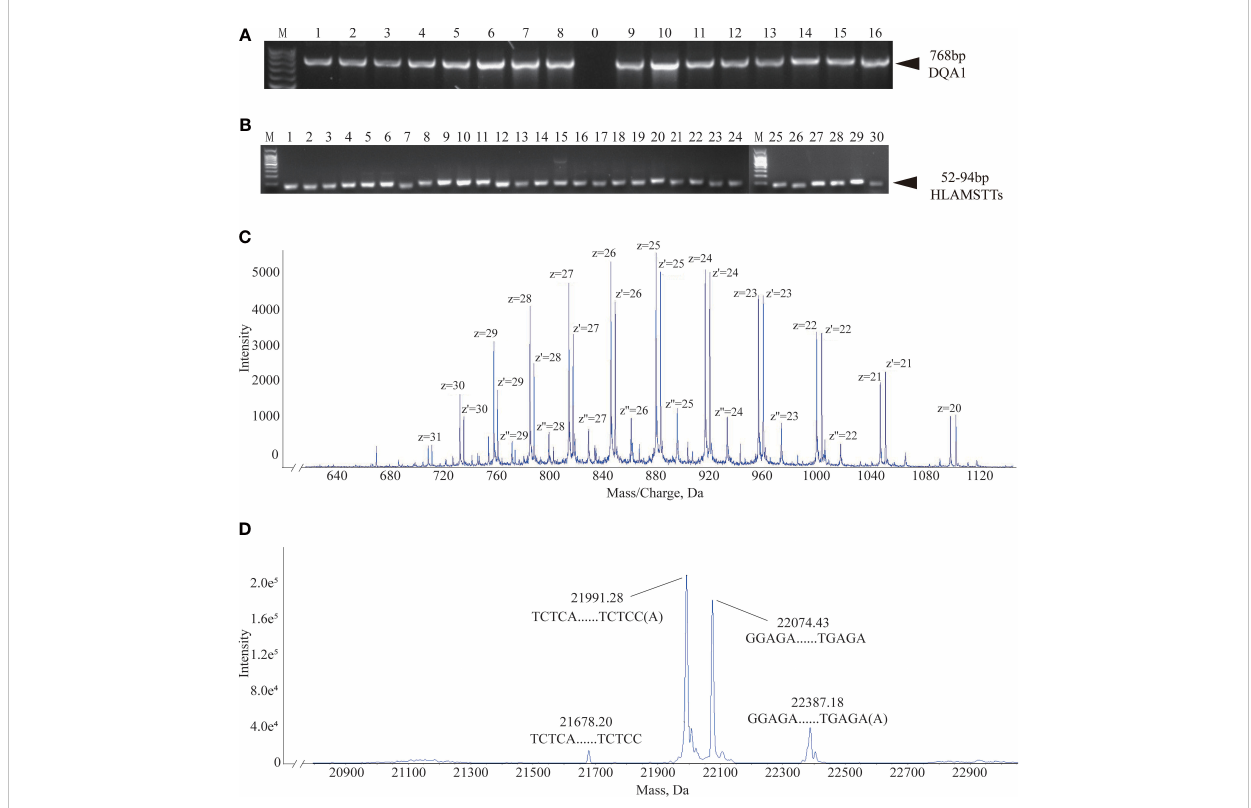
FIGURE 4 Agarose gel electrophoresis and MS data interpretation. (A) Agarose gel electrophoresis of 16 HLA-DQA1 showed bands at 768 bp. (B) HLAMSTT gel electrophoresis of Sample 2 showed bands at 52 – 94 bp. (C) Mass spectrum of Sample 2 No. 26 HLAMSTT with corresponding mass-to-charge ratio (m/z) peaks. The m/z of the HLAMSTT was between 700 and 1100 Da, and the maximum intensity of the signal was between 5000 and 6000. (D) Mass spectrum of Sample 2 No. 26 HLAMSTT with corresponding molecular weight peaks. The molecular weights of the two highest peaks were 21992.11 Da and 22075.32 Da, corresponding to the DNA single strands TCTCAGGCTCCCAGTGTTTCAGAAGAGGCTGGTCCAGGCCCCAGTGCTCC ACCTTGCAGTCATAACTCTCC(A) and GGAGAGTTATGACTGCAAGGTGGAGCACTGGGGCCTGGACCAGCCTCTTCTGAAACACTGGGAGCCTGAGA, respectively; their intensities were 1.8e5 and 1.5e5,